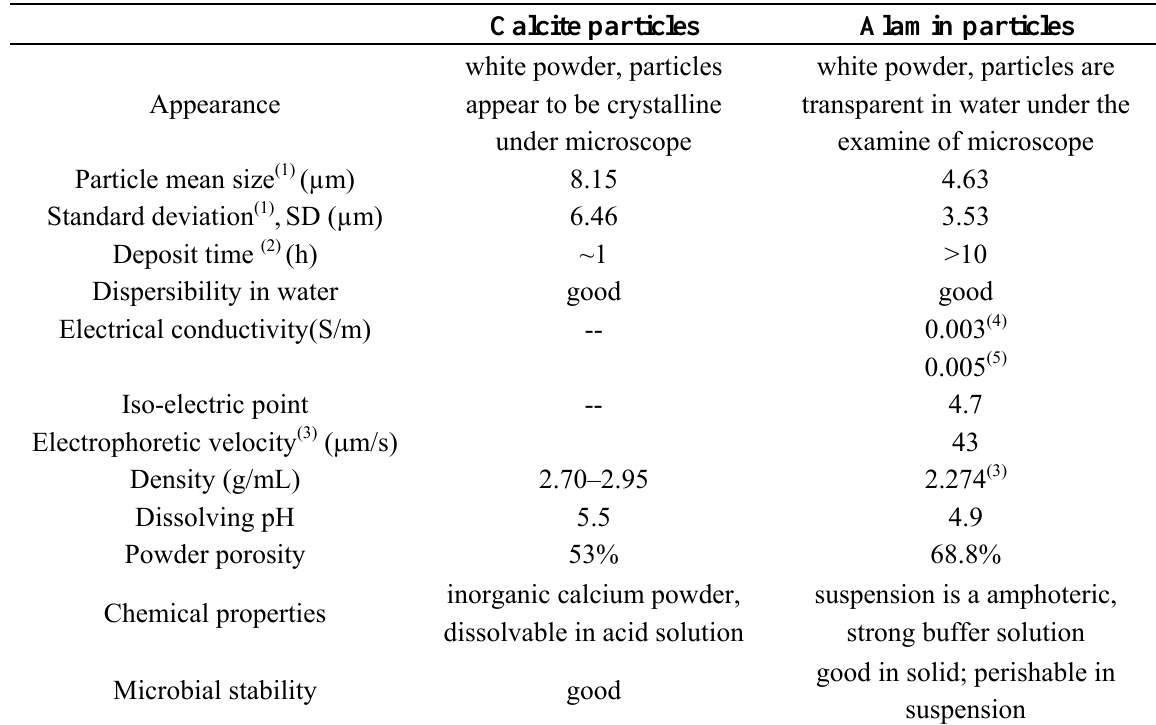
Table 2. Summary of the physical properties of calcite and Alamin